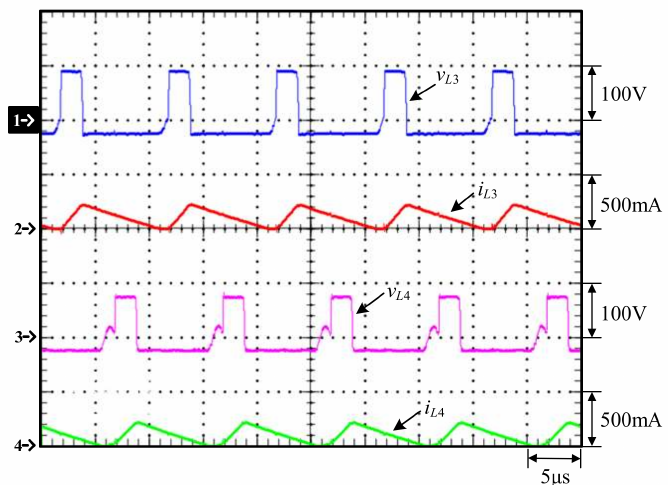
Figure 27. Measured waveforms relevant to 25% of the rated load: (1) v L 3 ; (2) i L 3 ; (3) v L 4 ; (4) i L 4